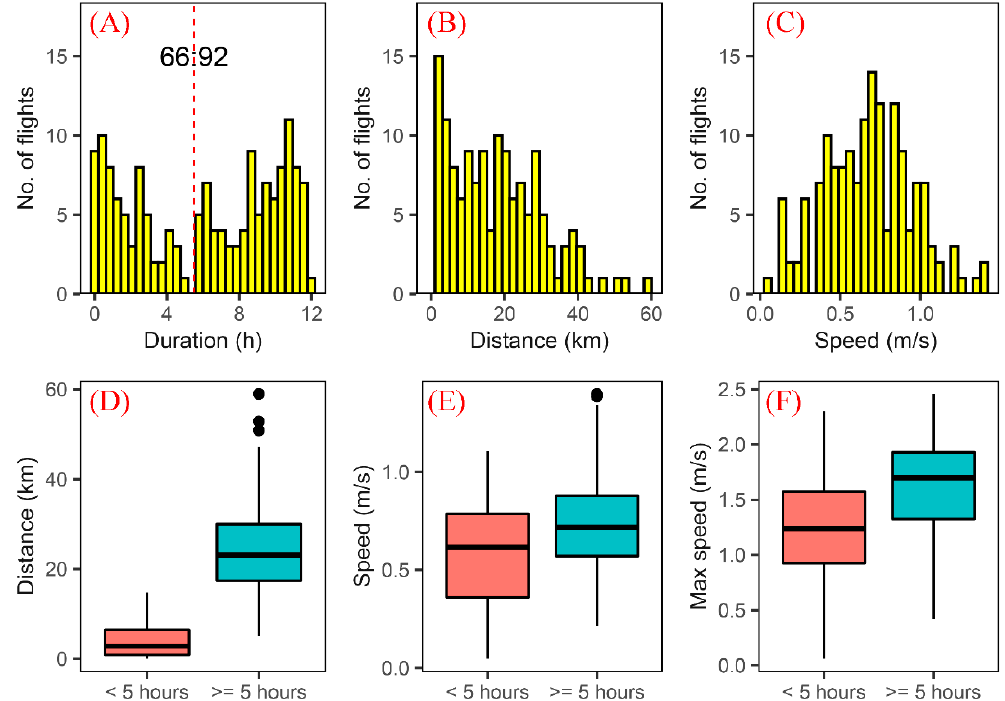
Figure 2. Flight capability of S. frugiperda moths in the first 12 h of testing. The distribution of ( A ) flight duration, ( B ) distance and ( C ) speed. Based on the flight duration, the experimental moths can be divided into two groups, one with flight duration of <5 h, and another with flight duration ≥ 5 h. Compared with the former group, the latter had stronger flight capability, a higher mean flight speed ( E ) and maximum flight speed ( F ), and thus, they covered longer flight distances ( D ). Flight distance also varied greatly between individuals, and its frequency distribution was skewed with a long tail and a large coefficient of variation (0.82). The mean flight distance of all individuals was 16.09 ± 1.05 km (mean ±S.E., df = 158), and the longest flight differences in flight distance among individuals at different ages ( χ 2 = 11.61, df = 5, p = 0.040) but not between females and males ( χ 2 = 1.74, df = 1, p = 0.187). In detail, the mean